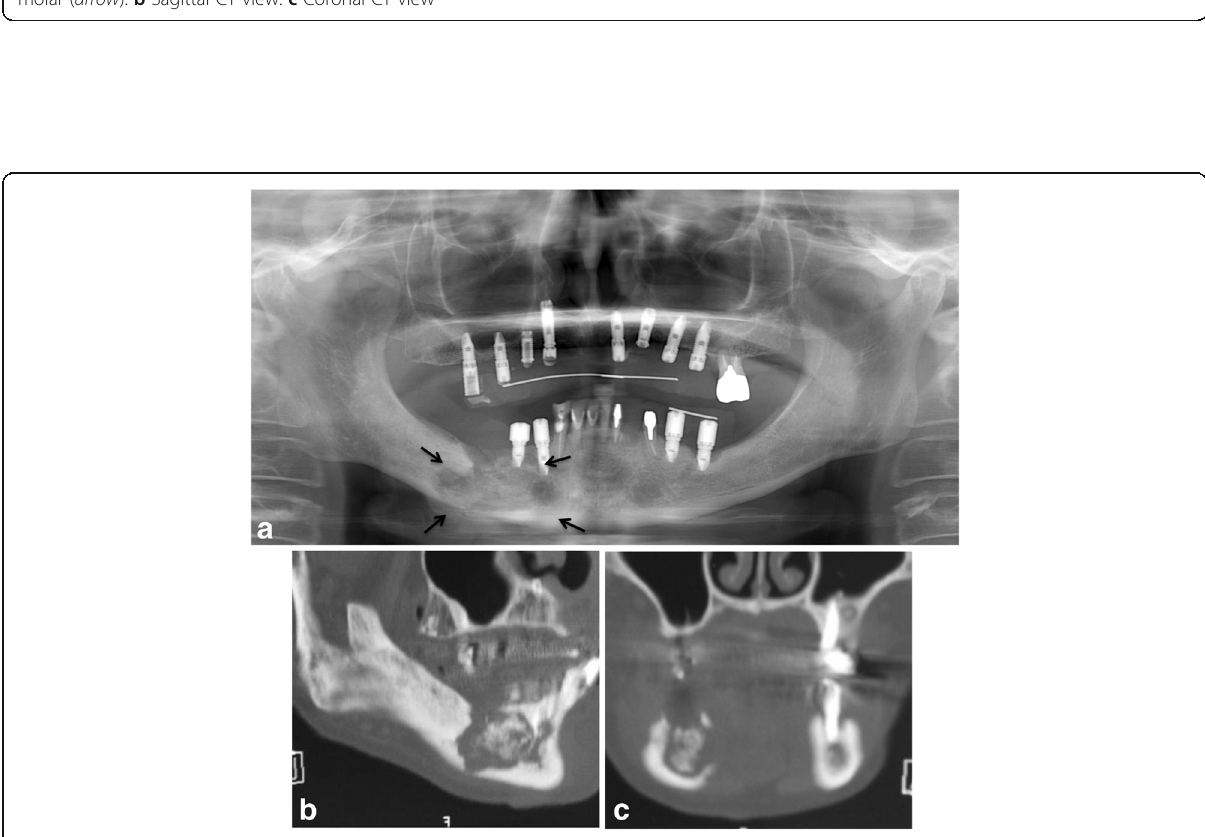
Fig. 3 a Panoramic radiograph showing the sequestrum separation after 5 months of teriparatide therapy ( arrows ). b Sagittal CT view. c Coronal CT